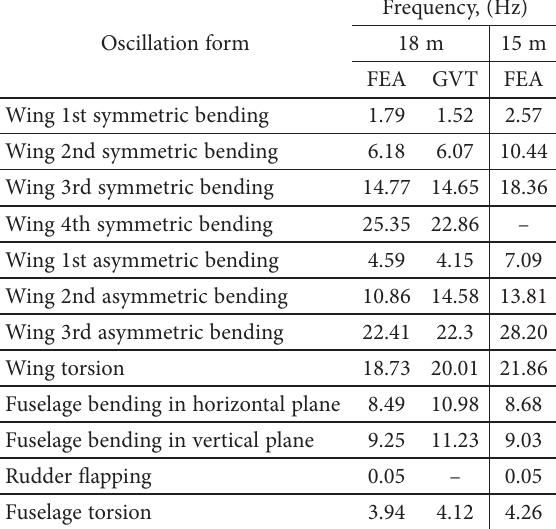
Table. Sailplane LAK-17B normal modes: